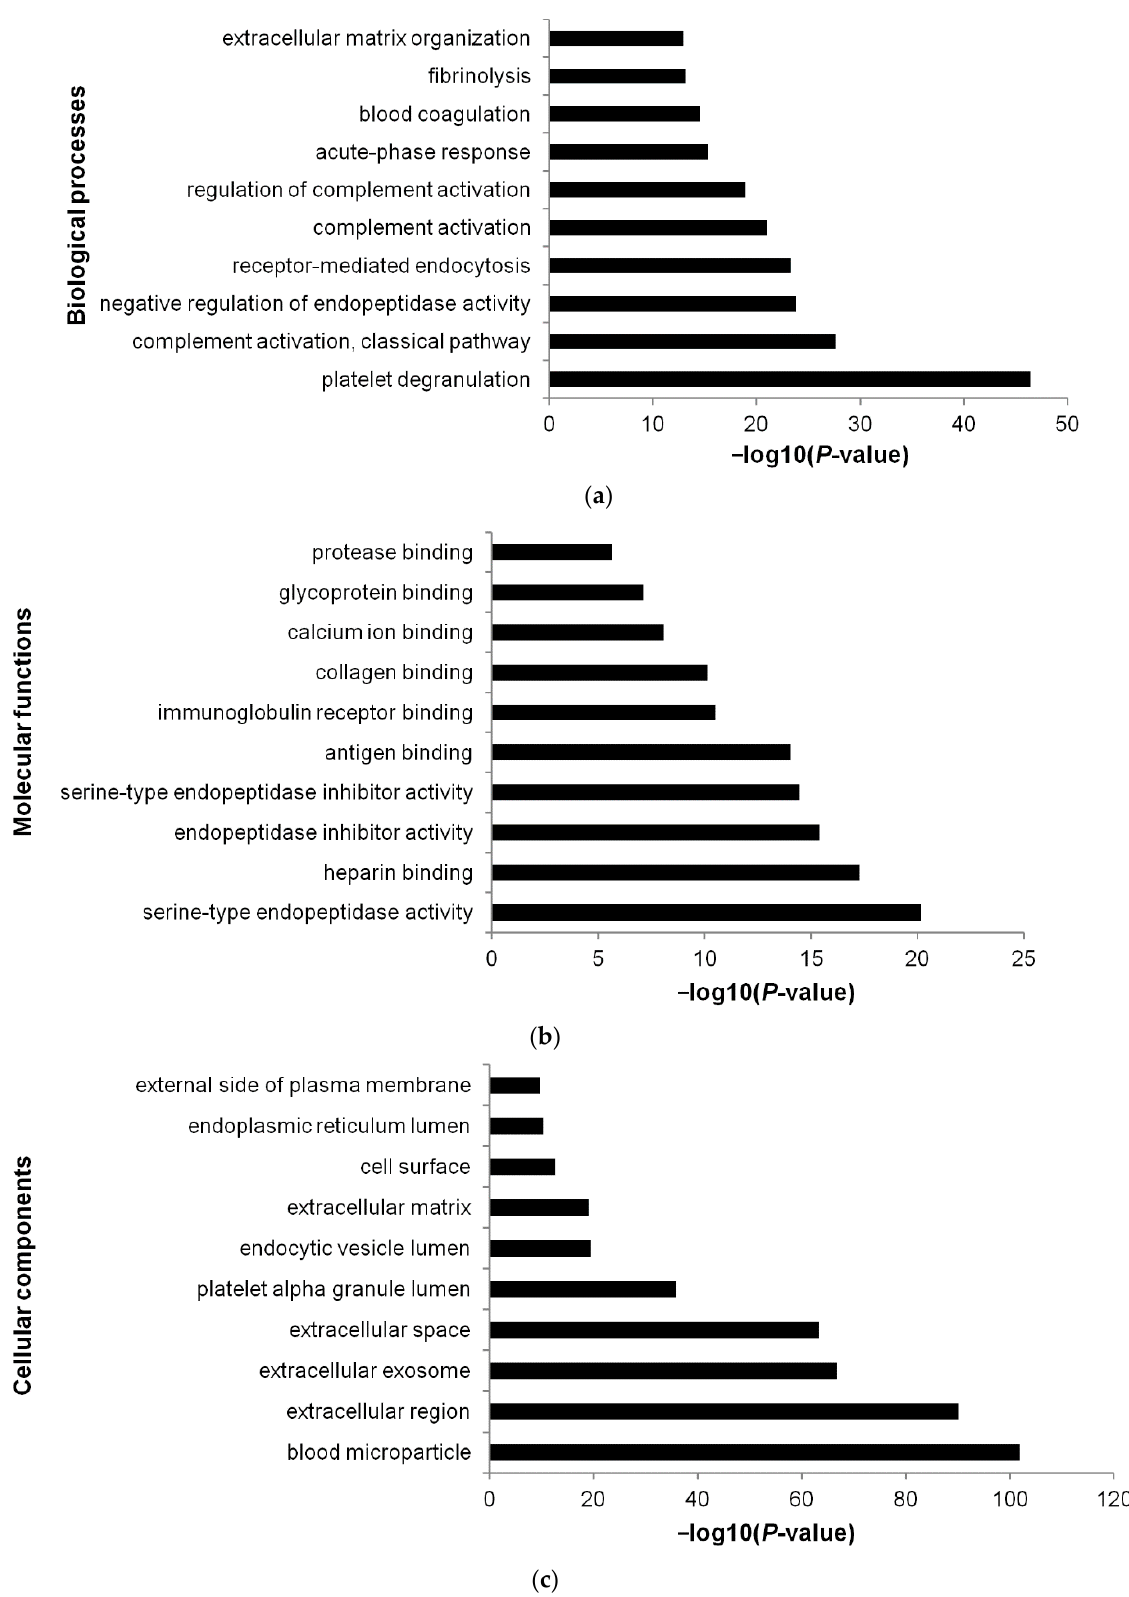
Figure 8. Top 10 most significant (Benjamini-corrected p < 0.01) biological processes ( a ), molecular functions ( b ), and cellular components ( c ) associated with plasma EV proteins of non-relapsed HL according to DAVID Bioinformatics Resources interrogated with the 161 proteins identified by LC–MS/MS (Supplementary Table S2).